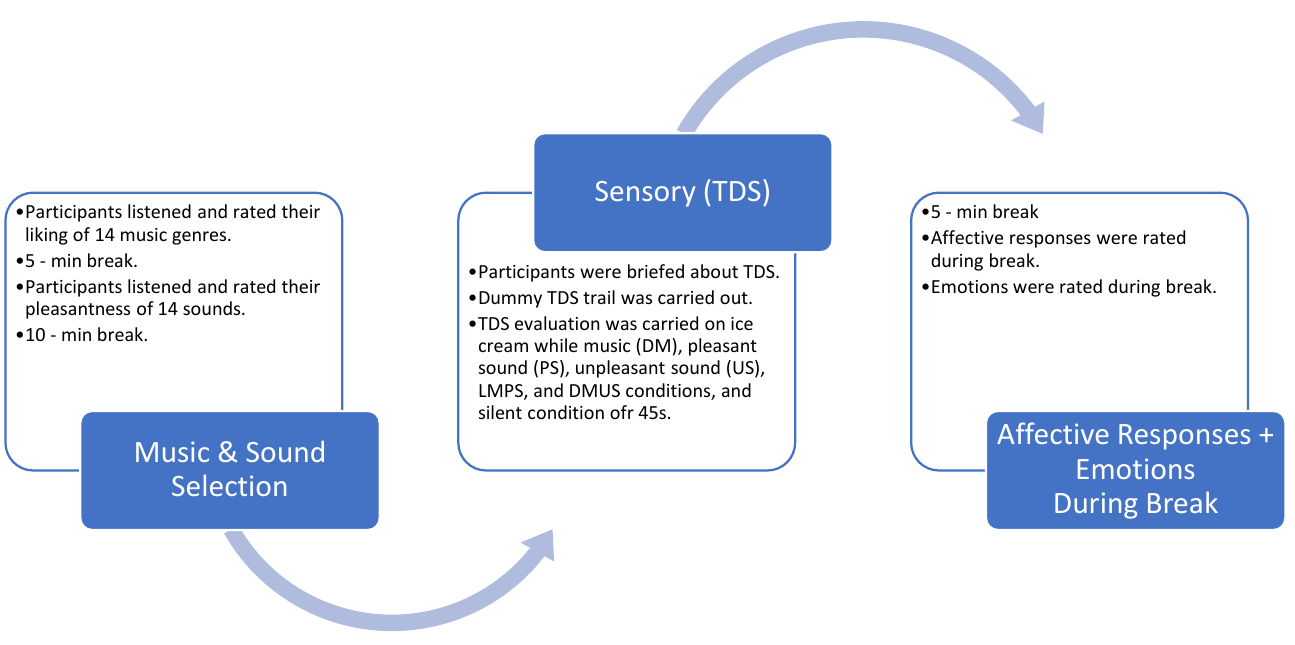
Figure 1. Experimental protocol for the